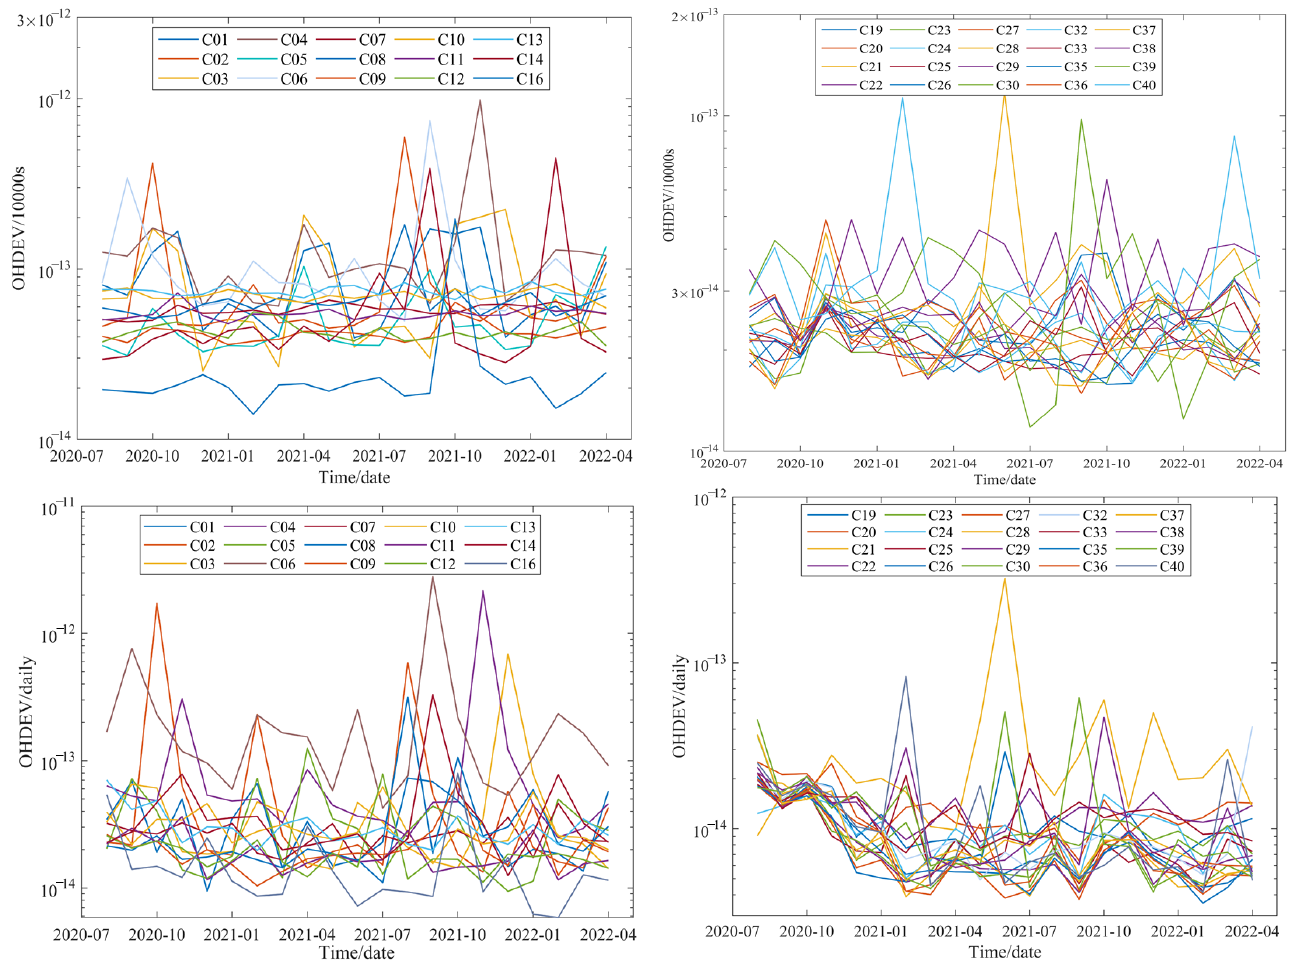
Figure 10. Sequence diagram of frequency daily stability.